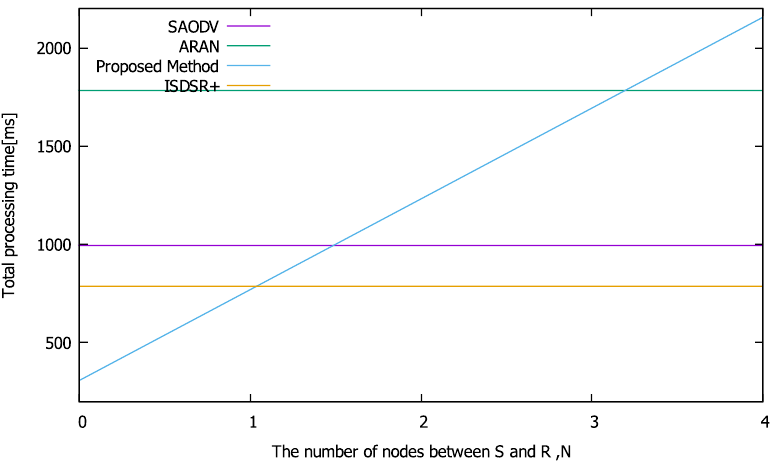
Figure 5. Calculation time performances when n = 5.